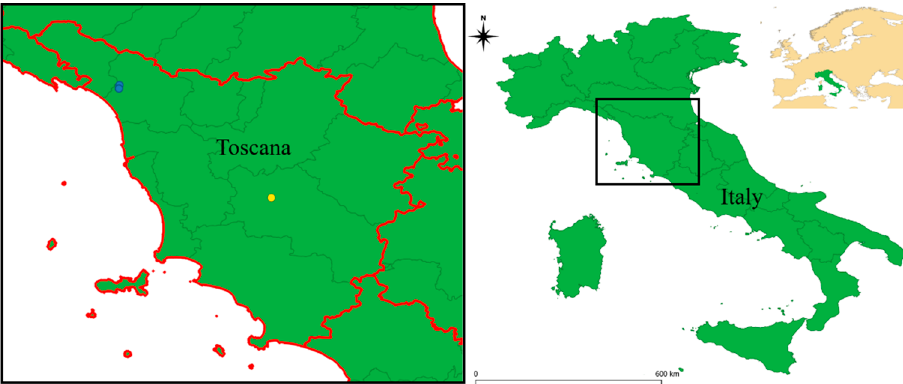
Figure 1. Map indicating the sampled populations. Blue labels indicate natural hybrid populations, whereas yellow indicates those introduced outside the natural distribution of Speleomantes . The coordinates of the surveyed sites are not provided to increase species protection [13].